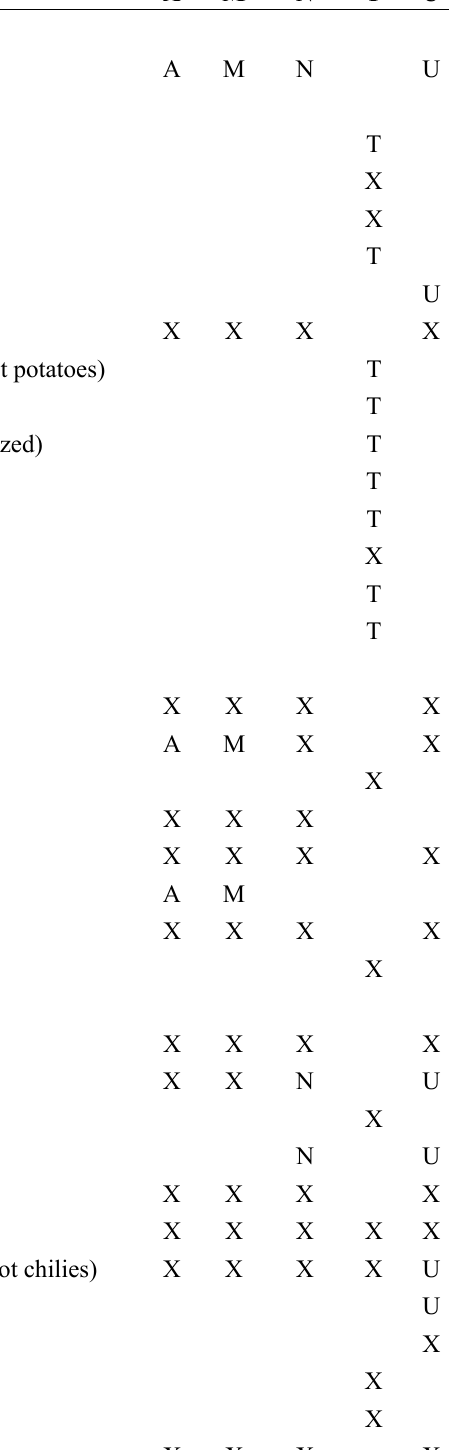
Table 3. Traditional ethnic recipes based on manioc where A stands for Andoke, M for Muinane, N for Nonuya, T for Tikuna and U for Uitoto. Recipes known by different ethnic groups but which are not exclusive to any one group are identified with an